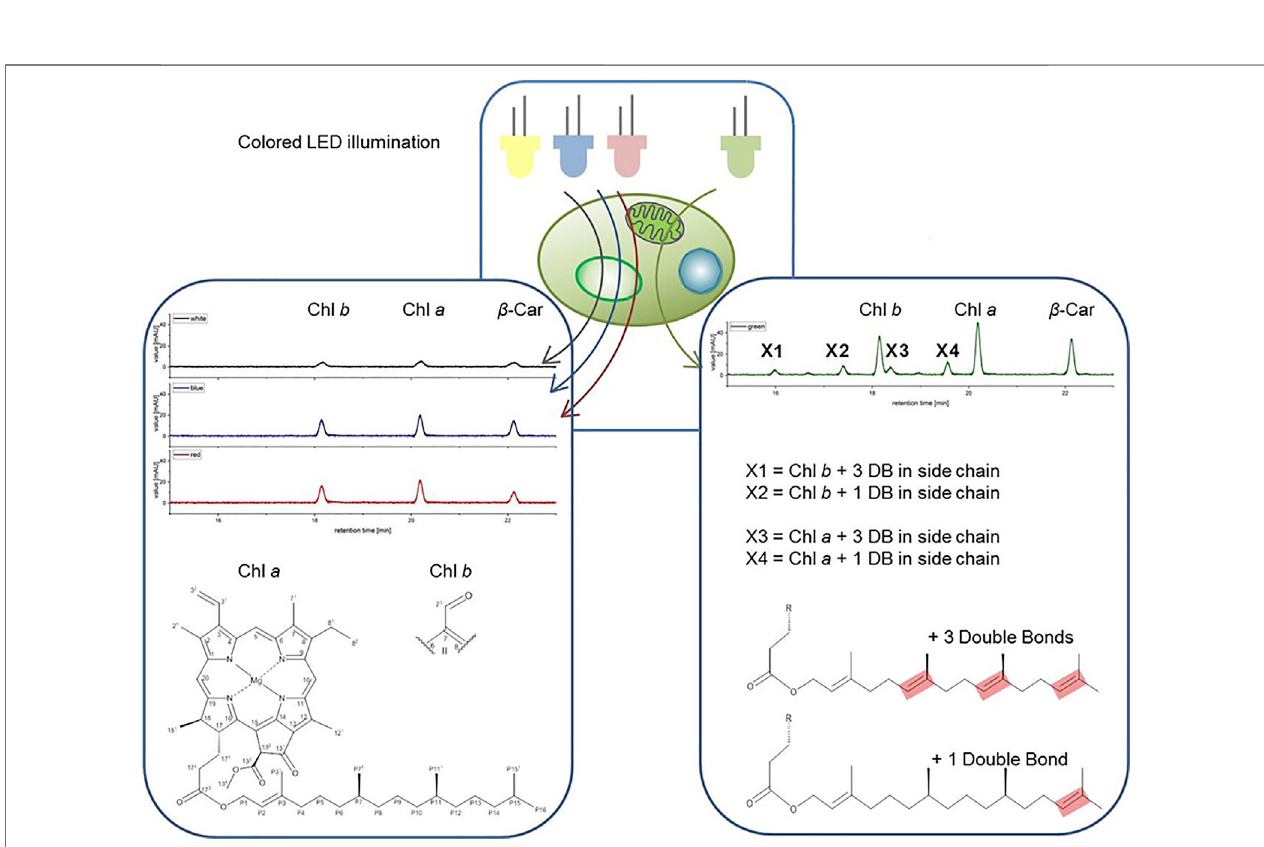
FIGURE 7 | Structures of the pigments X1-X4 shown on right side. Green color LED illumination of Picochlorum sp. leads to the accumulation of additional pigments peaks in the exponential growth phase, identi fi ed as geranylgeranylated derivatives of Chl a and Chl b (shown on left side).